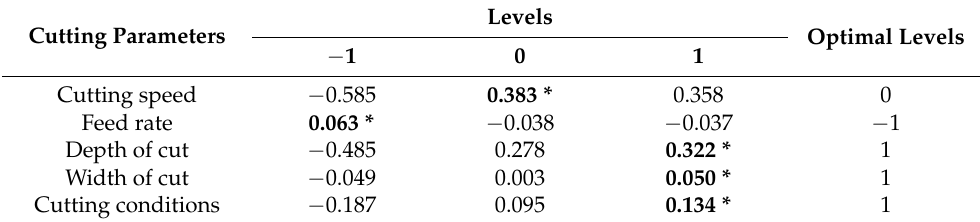
Table 11. Optimal levels based on average assessment score. Cutting